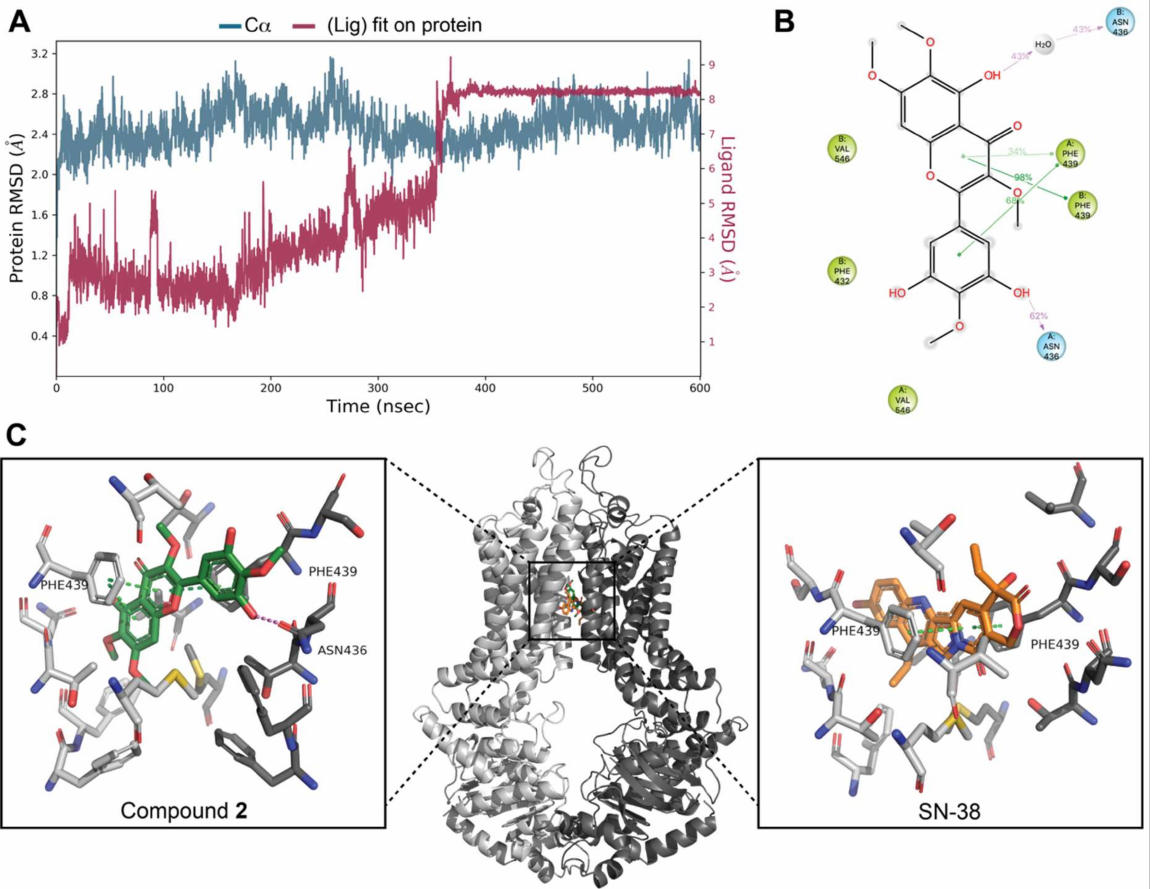
Figure 11. ( A ): Time trace of root mean square deviation (RMSD) of ligand position relative to that at the start of the MD simulation. ( B ): Details of interactions between BCRP and 2 during the 380–600 ns period of the MD simulation. Hydrogen bonds and water-bridged interactions are described by the violet lines, π – π stacking interactions are indicated by green lines and hydrophobic interactions are shown as grey spheres. Percentages indicate the fraction of nanoseconds where the interactions occur. ( C ): Binding site of BCRP (middle) with enlarged views of binding poses of 2 (left) and SN-38 (right) [28]. The active BCRP dimer consists of two monomeric units A (coloured light grey) and B (dark grey); compound 2 is coloured green, and SN-38 is coloured orange. Zoomed views show residues within 5